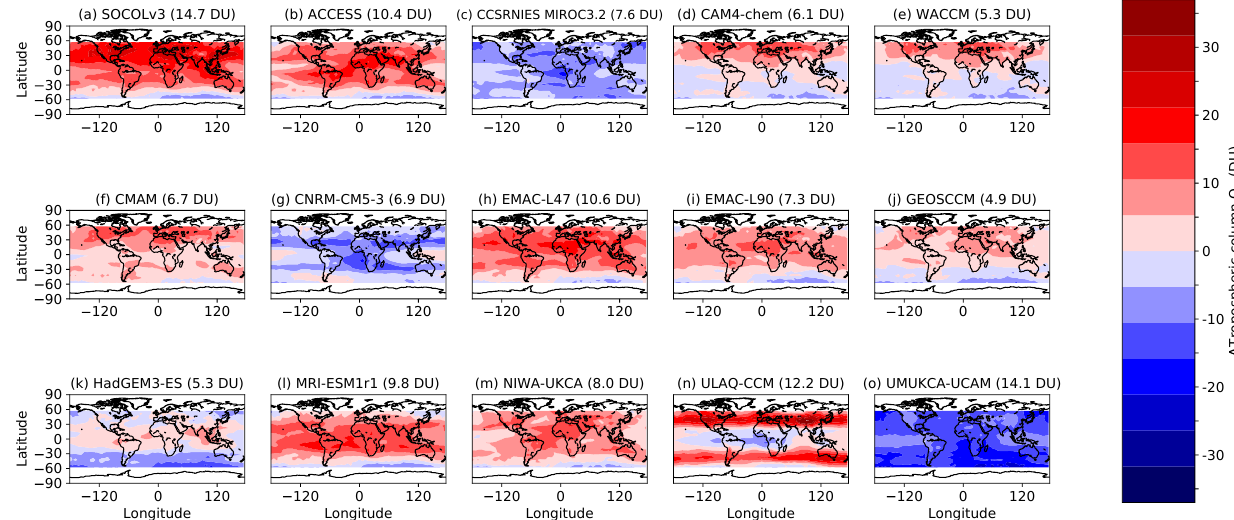
Figure 7. Difference between annual-mean year 2005 tropospheric column ozone in CCMI models compared with OMI/MLS, i.e. model minus OMI/MLS. The root-mean-square error for each model compared with OMI/MLS is indicated in the